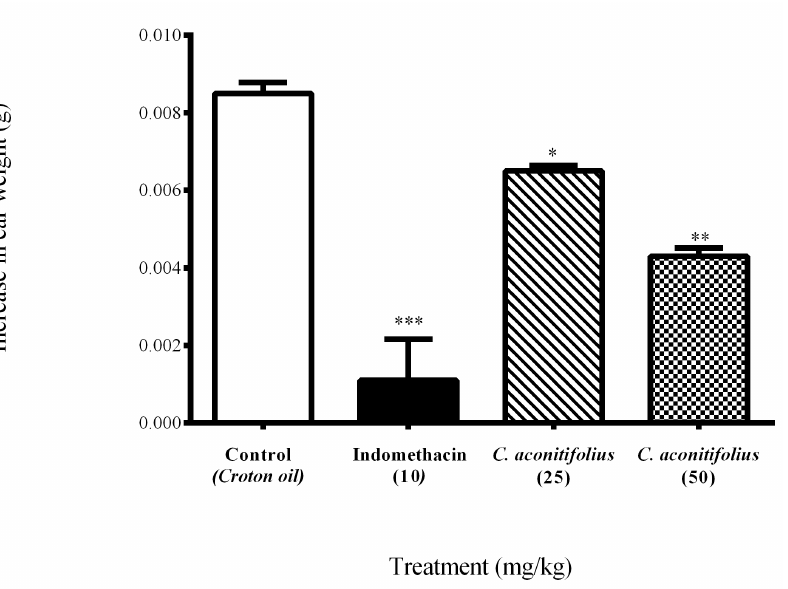
Figure 2. Anti-inflammatory effect by topical application of C. aconitifolius ethyl acetate extract on croton oil-induced ear edema. C. aconitifolius ethyl acetate extract in both doses decreased the ear edema. Indomethacin was used as positive control. Results are expressed as means ± SEM. N = 6. * p < 0.05; ** p < 0.01; *** p < 0.001. One-way ANOVA was followed by Dunnett’s test. Table 4. Ear weight differences and inhibition percentage in croton-oil-induced ear edema test.